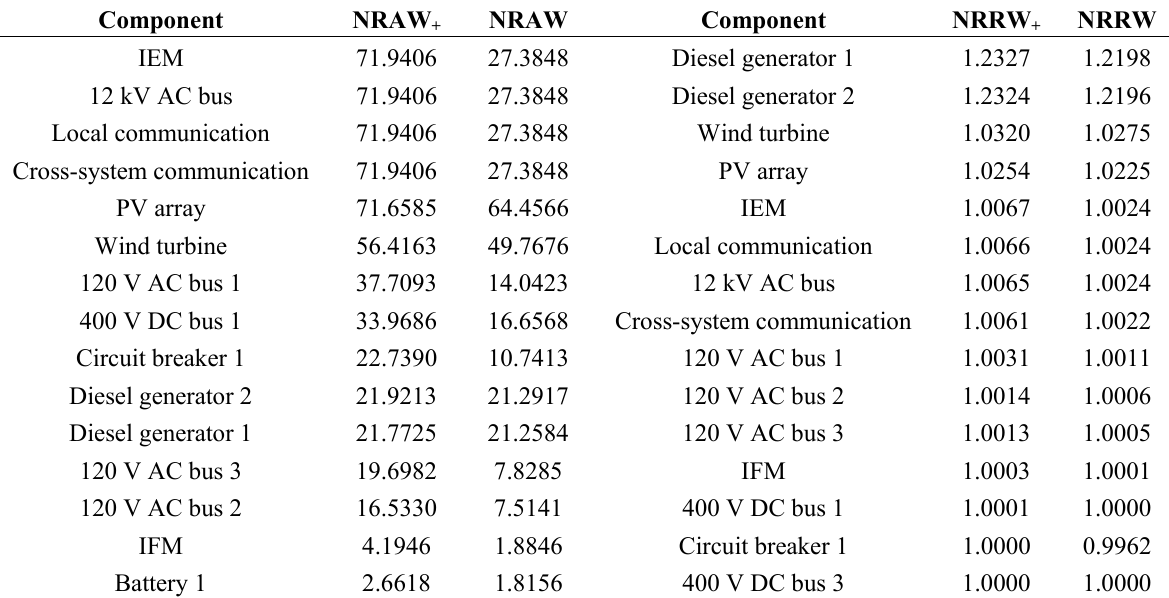
Table 4. Importance measures for selected components in the local